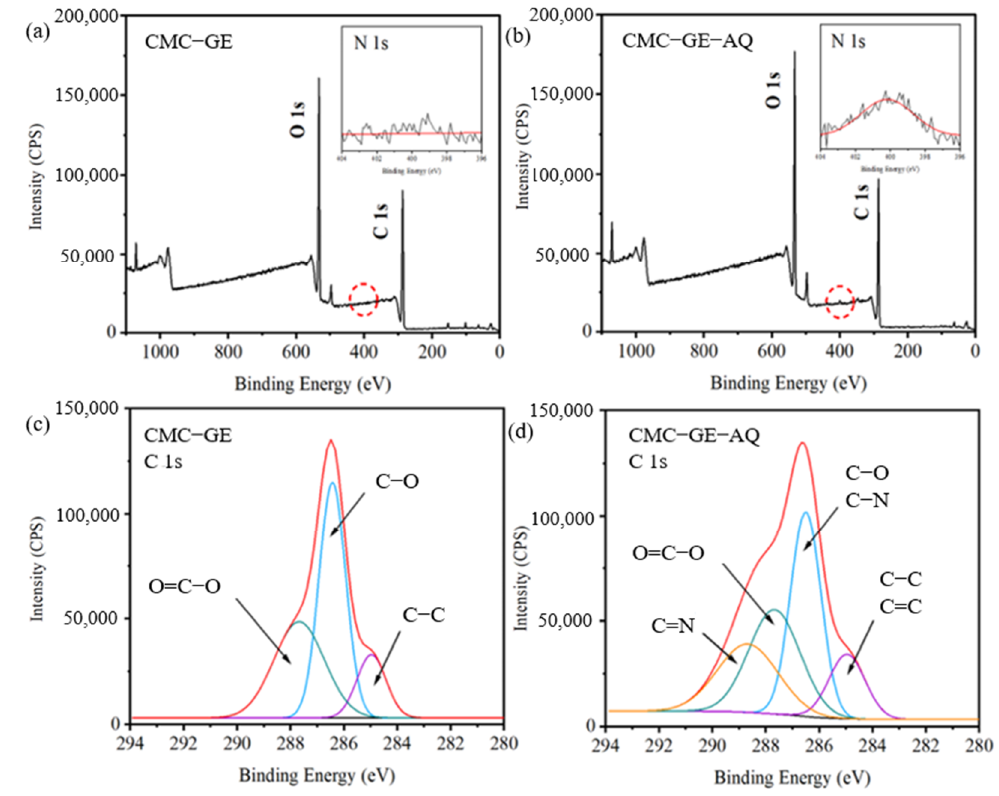
Figure 2. XPS spectra of ( a , c ) CMC−GE and ( b , d ) CMC−GE−AQ. (Inset: High−resolution XPS spectra of the N 1s peak. ( c , d ) High−resolution XPS spectra of the C 1s peak.)